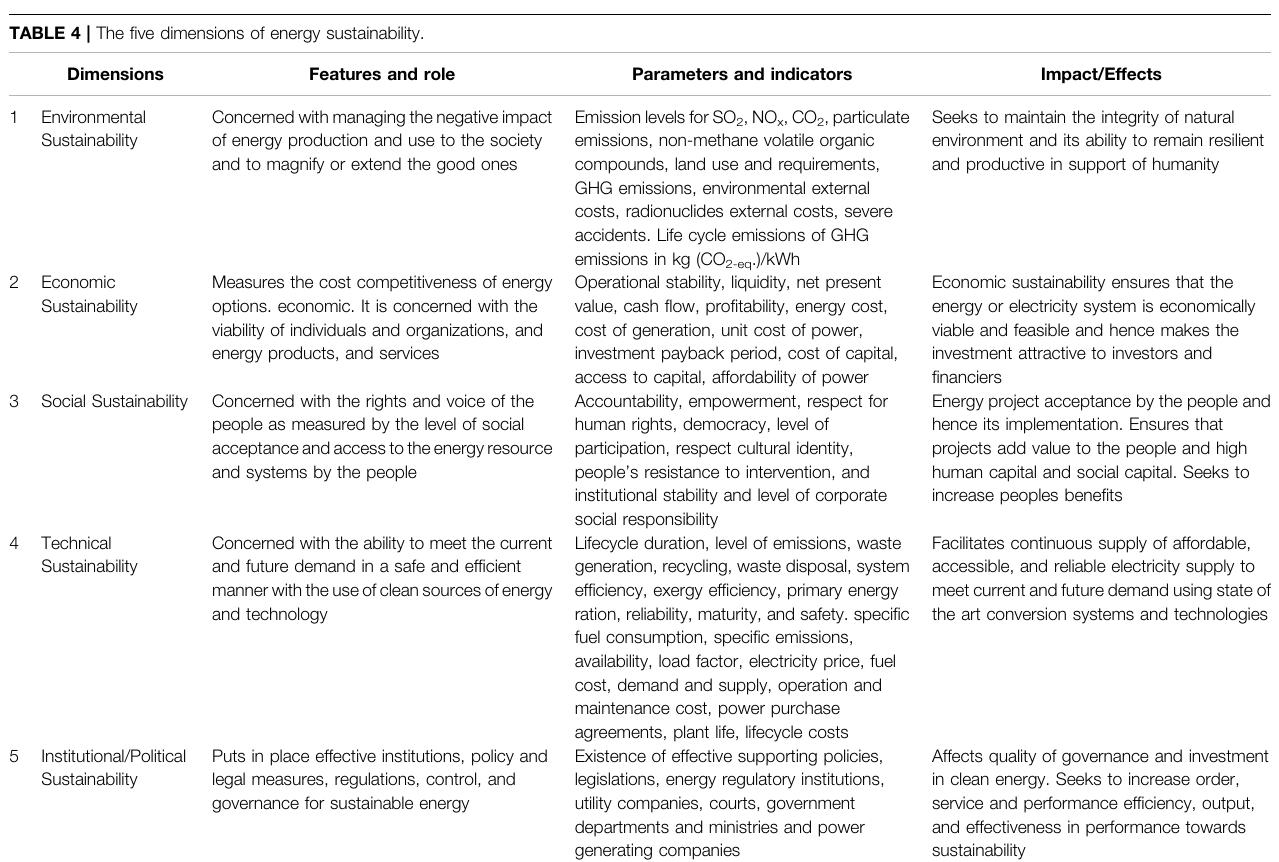
TABLE 4 | The fi ve dimensions of energy sustainability. Dimensions Features and role Parameters and